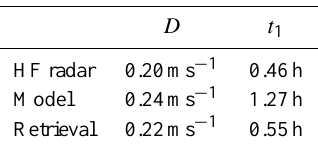
Table 3. M2 amplitude and the time of maximum strength of the radial current component as observed from the Wangerooge station as well as simulated from the original model results and the final